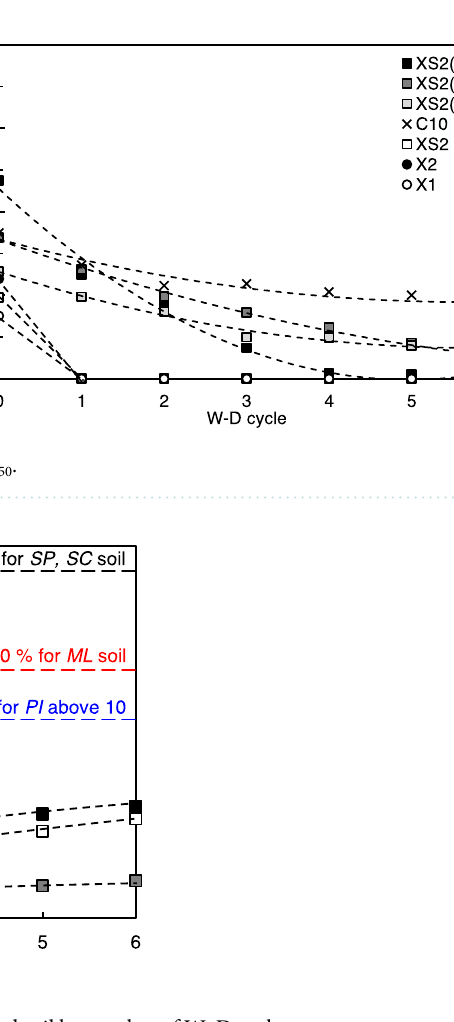
Figure 9. Variation of cumulative mass loss of XS-treated soil by number of W–D